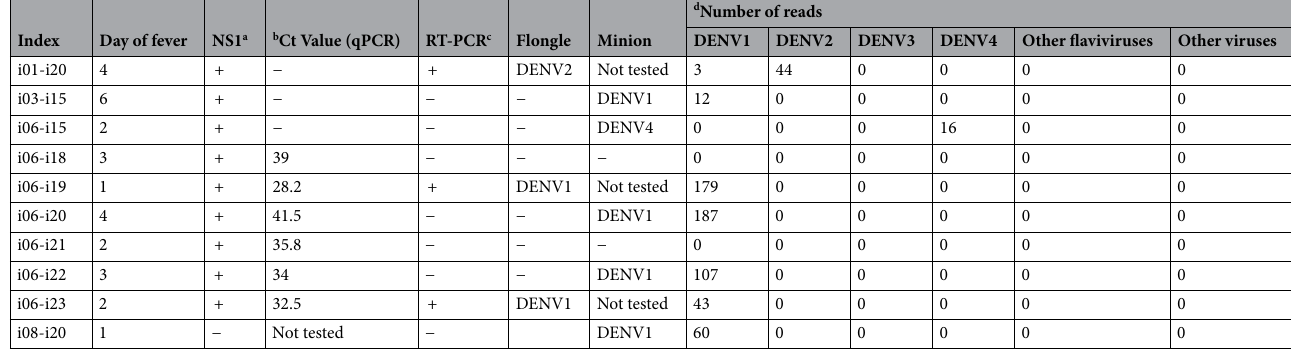
Table 2. Data of the positive results for RT-PCR and sequencing obtained from clinical samples in Vietnam. Viral RNA was extracted from 114 serum sample, then subjected to pan-flavivirus RT-PCR and sequencing. First-round of sequencing was carried out using a Flongle flowcell. Positive samples were then excluded from the second-round sequencing (using a MinION flowcell). a As a comparison, the samples were also screened with the NS1 antigen test. b Samples positive for NS1 were also subjected to the CDC based DENV-1-4 Real-Time RT-PCR Multiplex Assay. c Prior to sequencing, 1 µL of PCR product were visualized on agarose, alongside 100 bp DNA ladder (Supplementary Fig. S5). d Reads meeting the criteria were counted at the end of analysis and presented